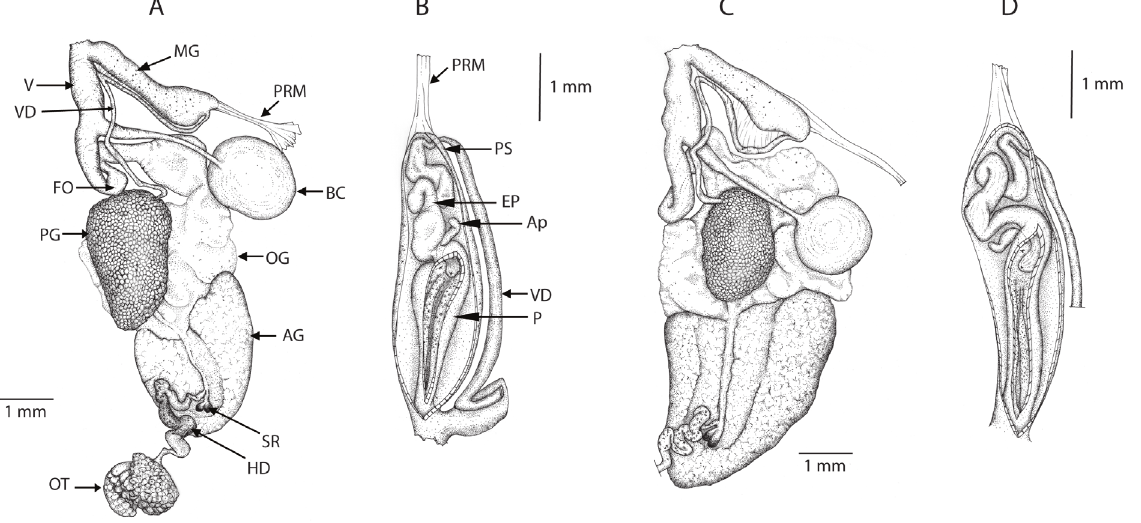
Fig. 8. Oxyloma salleanum (L. Pfeiffer, 1850). Spring Garden Lake, Volusia County, Florida [ O.